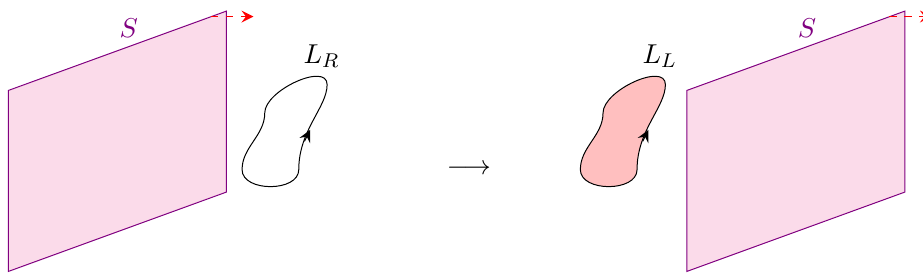
Figure 1 . A Wilson or a ’t Hooft loop L dragged across a non-invertible defect may become an improperly quantized disc operator. The red arrow denotes the orientation of the surface.